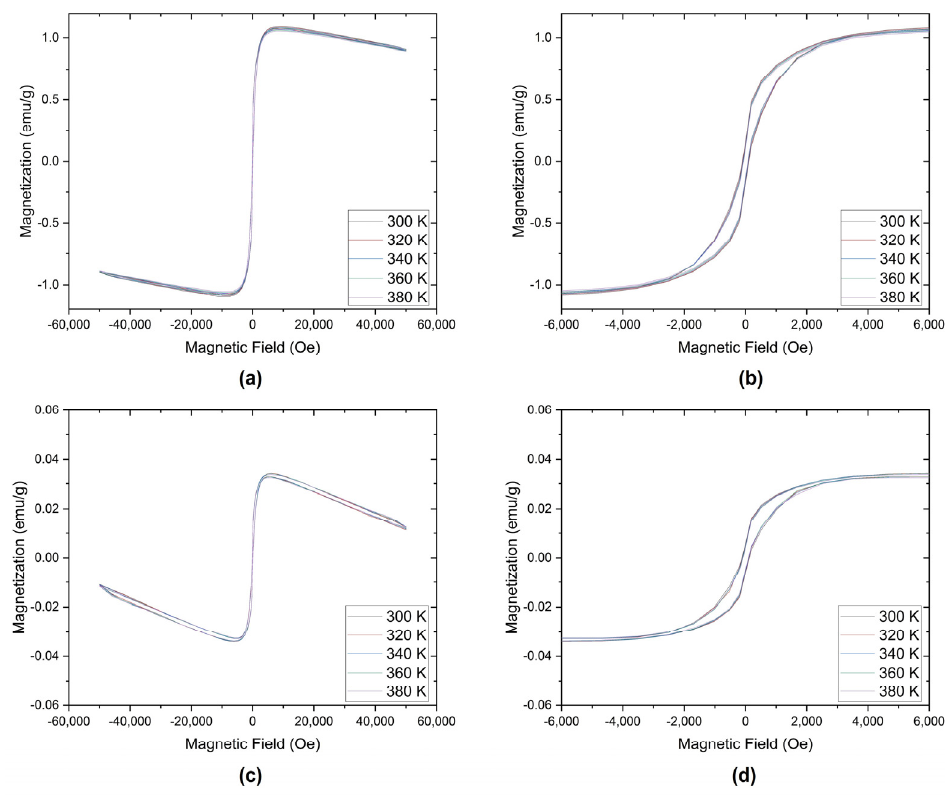
Figure 5. Magnetisation curve for the MWCNT ( a , b ), and 5 wt.% MWCNT/PDMS with random distribution ( c , d ).